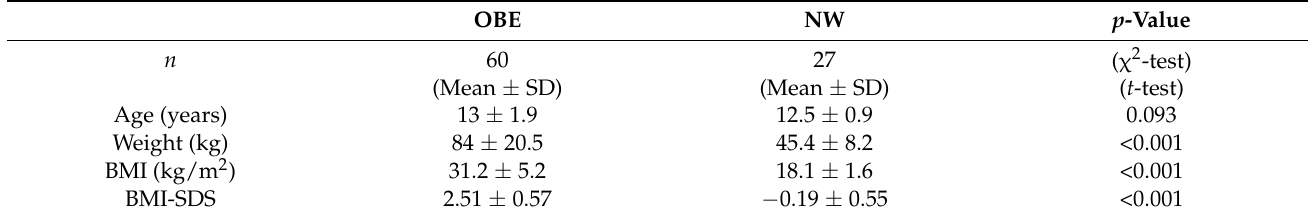
Table 1. Characteristics of the study population.